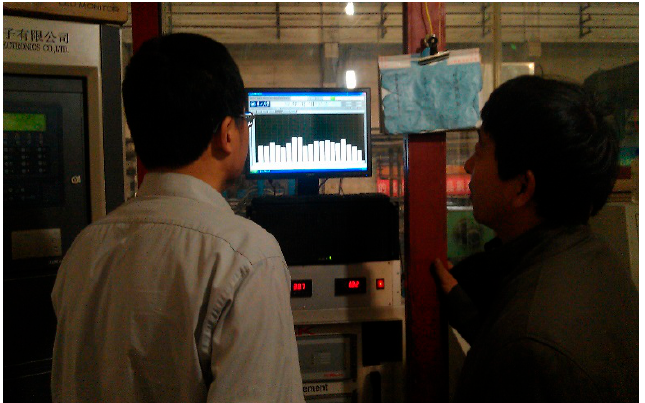
Figure 14. Shape signal processing system.